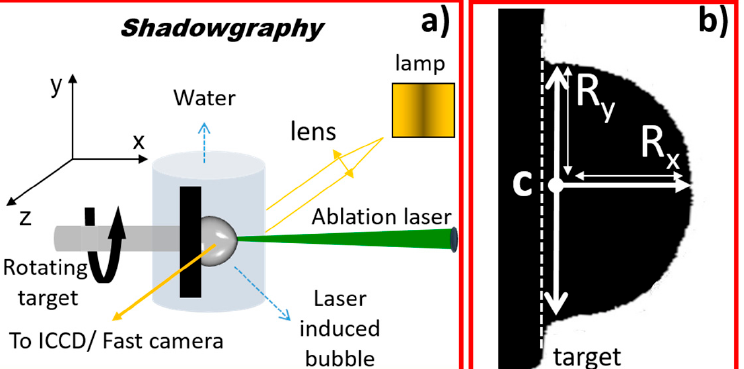
Figure 6. ( a ) Sketch of the experimental set-up for temporally resolved shadowgraph images. ( b ) Sketch of cavitation bubble where Ry is employed to determine the bubble radius, Rx is employed to determine the bubble front expansion. (The z and x axes are the shadowgraph and laser direction, respectively) .